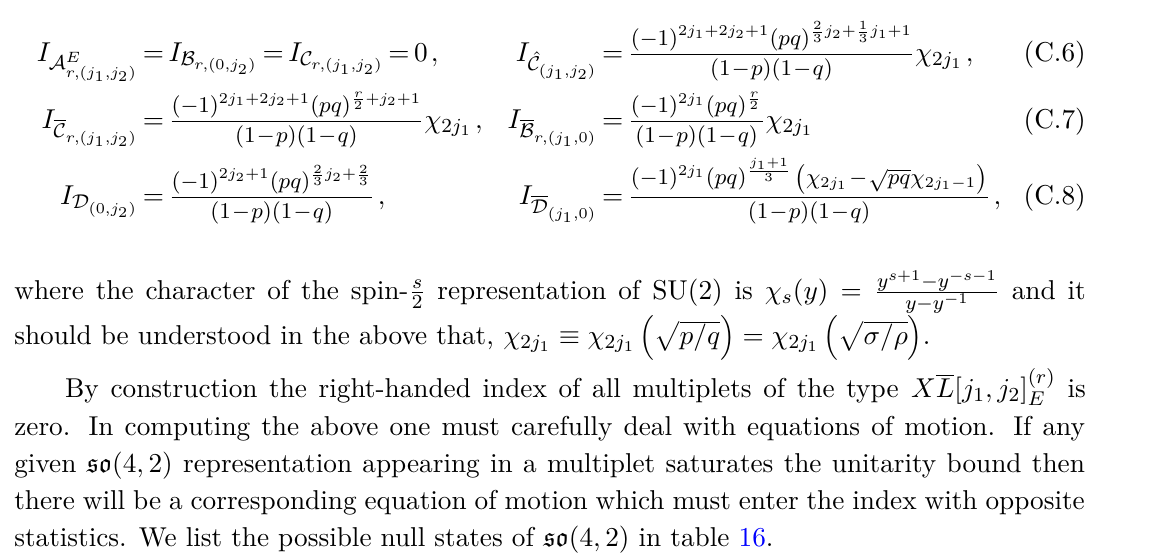
multiplet to the right-handed index